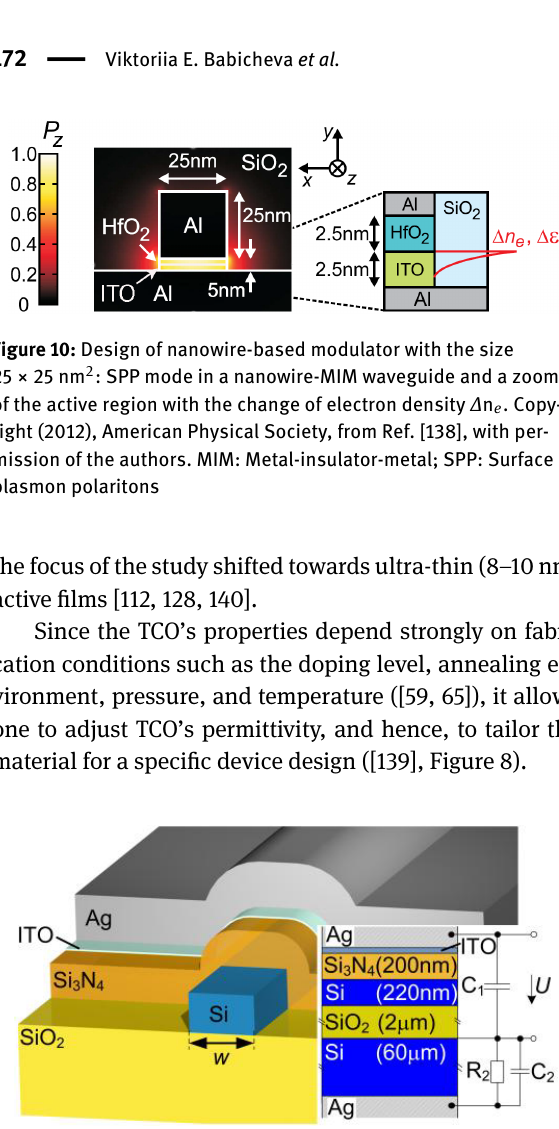
Figure 11: Hybrid design of plasmonic/photonic absorption modu- lator. Copyright (2011), OSA, from Ref. [128], with permission of the authors.